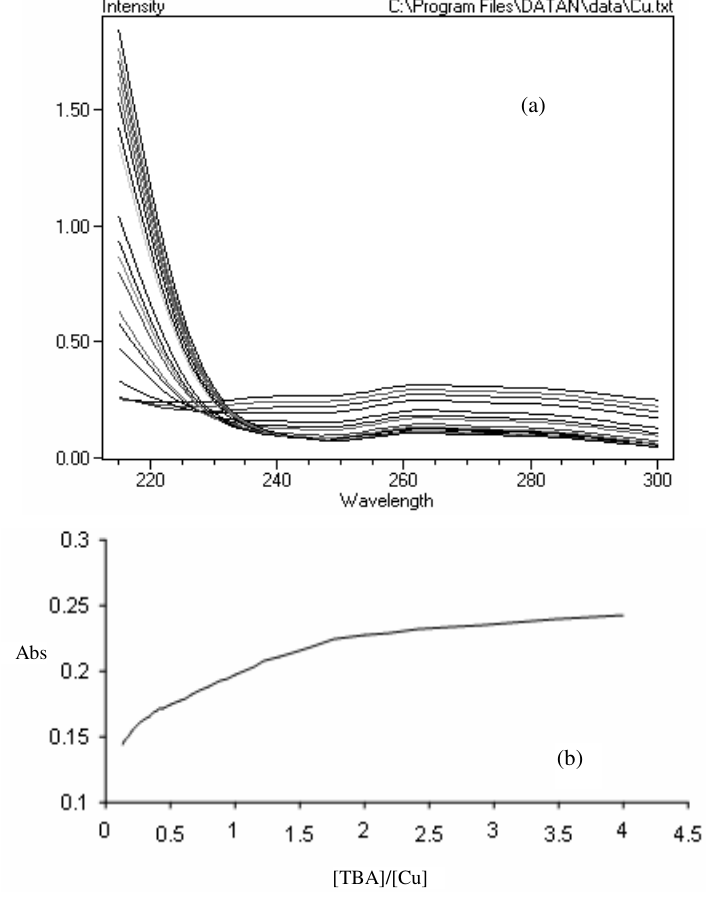
Figure 1. UV-Vis spectra for titration of TBA (1 × 10 -5 M) with Cu 2+ (5 × 10 -4 M) in = 264 nm, at T = 25 o C) (a) and the corresponding deionized water (Ic = 0.2 (% w/v), λ max molar ratio plot